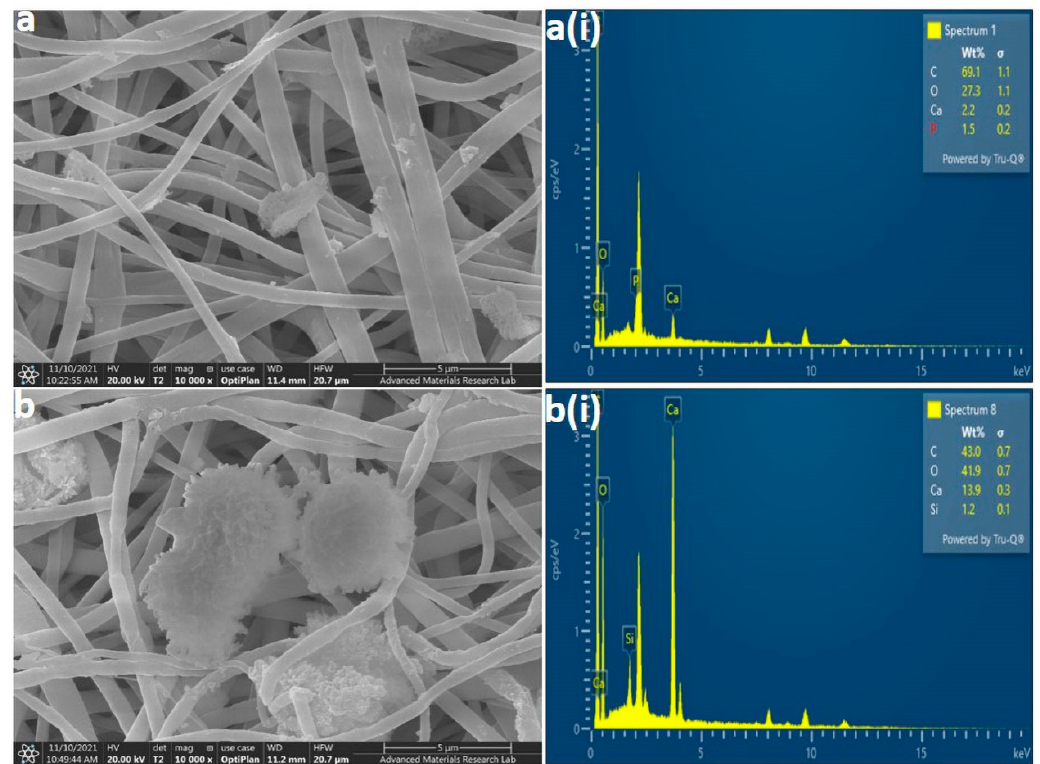
Figure 6. Representative FE ‐ SEM and the corresponding EDX images of electrospun PCLHA ( a , a ( i )) and PCLMTA ( b , b ( i )) after one ‐ month degradation study. The nanofibers are intact even after one month and the HA and MTA particles are obvious in the SEM and EDX analysis.